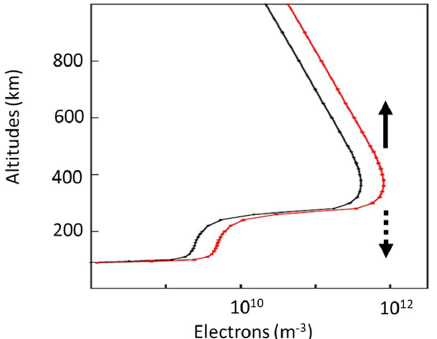
Figure 2. Vertical profiles from 90 to 1000km in altitudes of elec- tron number density in two conditions: pre-onset in black and af- ter accumulation in red. The nighttime sunspot maximum condition given in Prince Jr. and Bostick Jr. (1964) was used to plot the pre- onset condition. Vertical arrows directing upward and downward denote traveling ion acoustic waves propagating along the field lines from the density peak of the F layer.